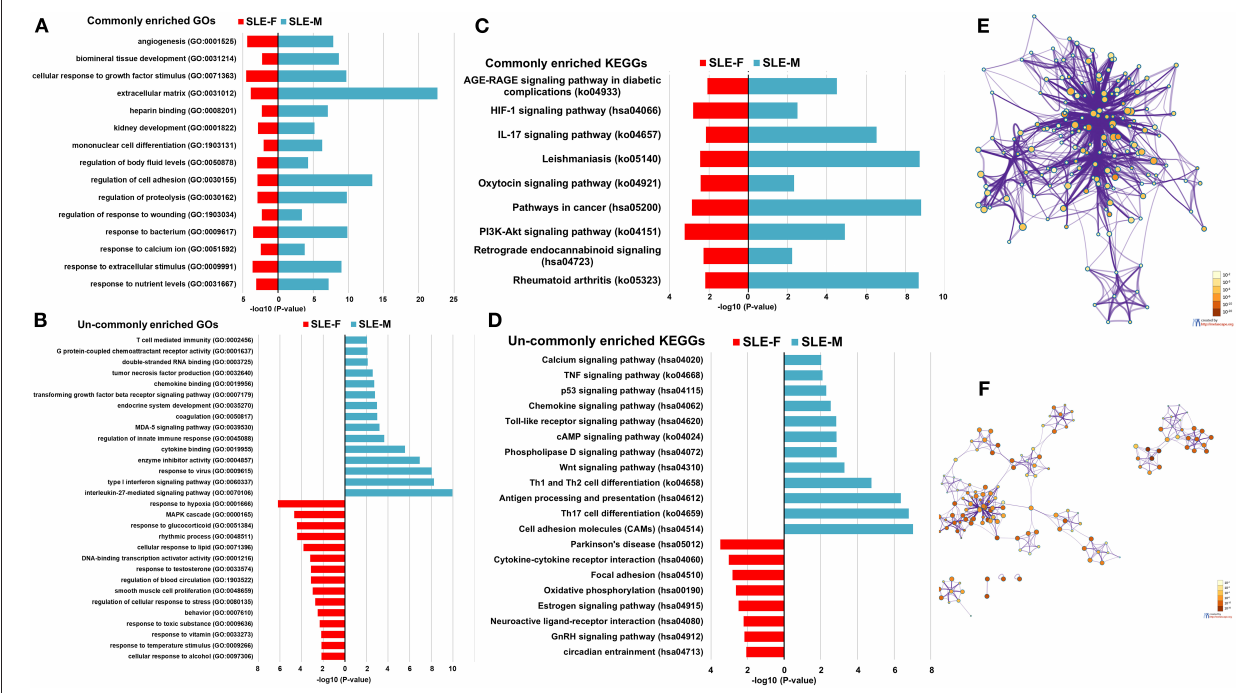
FIGURE 2 | Enrichment analysis of dysregulated protein-coding genes in SLE-F and -M placentas. (A) Commonly enriched GOs terms from both SLE-F and -M placentas. (B) Un-commonly enriched GO terms from SLE-F and -M placentas, respectively. (C) Commonly enriched KEGG terms from both SLE-F and -M placentas. (D) Un-commonly enriched KEGG terms from SLE-F and -M placentas, respectively. (E) Network of GO and KEGG enriched terms from SLE-F placentas colored by P -value, where terms containing more dysregulated genes indicate a more significant P -value. (F) Network of GO and KEGG enriched terms from SLE-M placentas colored by P -value, where terms containing more genes tend to have a more significant P -value. SLE, systemic lupus erythematosus; F, female; M, male; GO, Gene Ontology; KEGG, Kyoto Encyclopedia of Genes and Genomes.